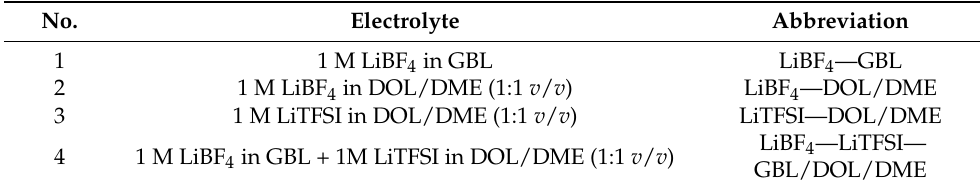
Table 1. Compositions of liquid